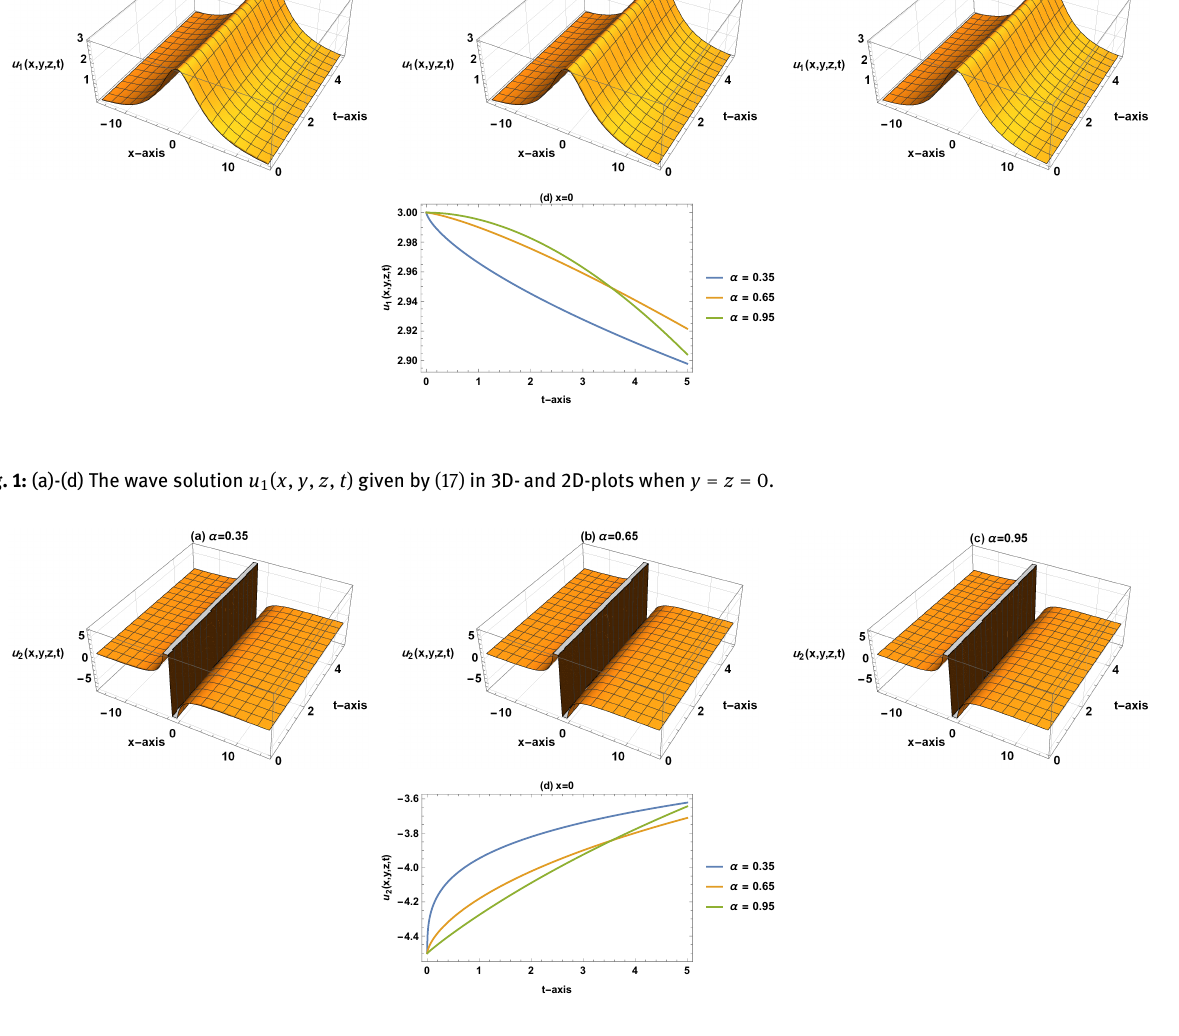
Fig. 2: (a)-(d) The wave solution u 2 ( x , y , z , t ) given by (20) in 3D-and 2D-plots when y = z = 0 .